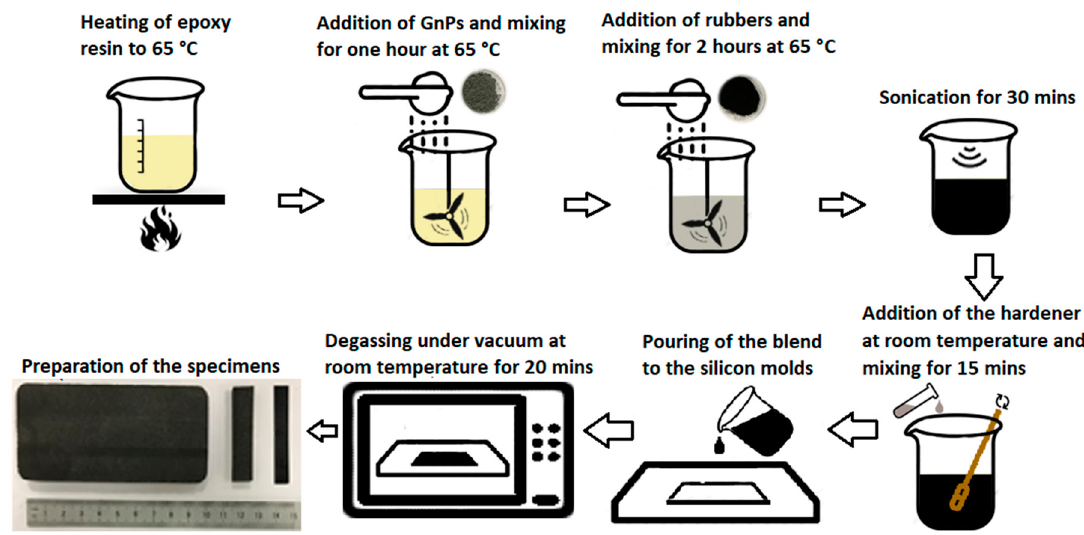
Figure 1. Manufacturing flow chart for the recycled ethylene propylene diene monomer (EPDM)-modified epoxy-based composites.